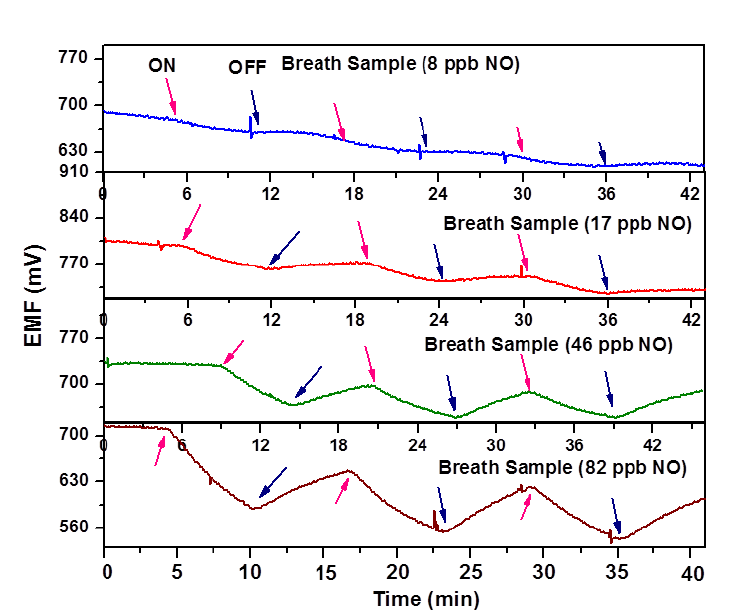
Figure 9. Response of a 20-sensor array using multiples of the unit device in Figure 7(A) towards ppb levels of NO in human breath (adapted from Reference